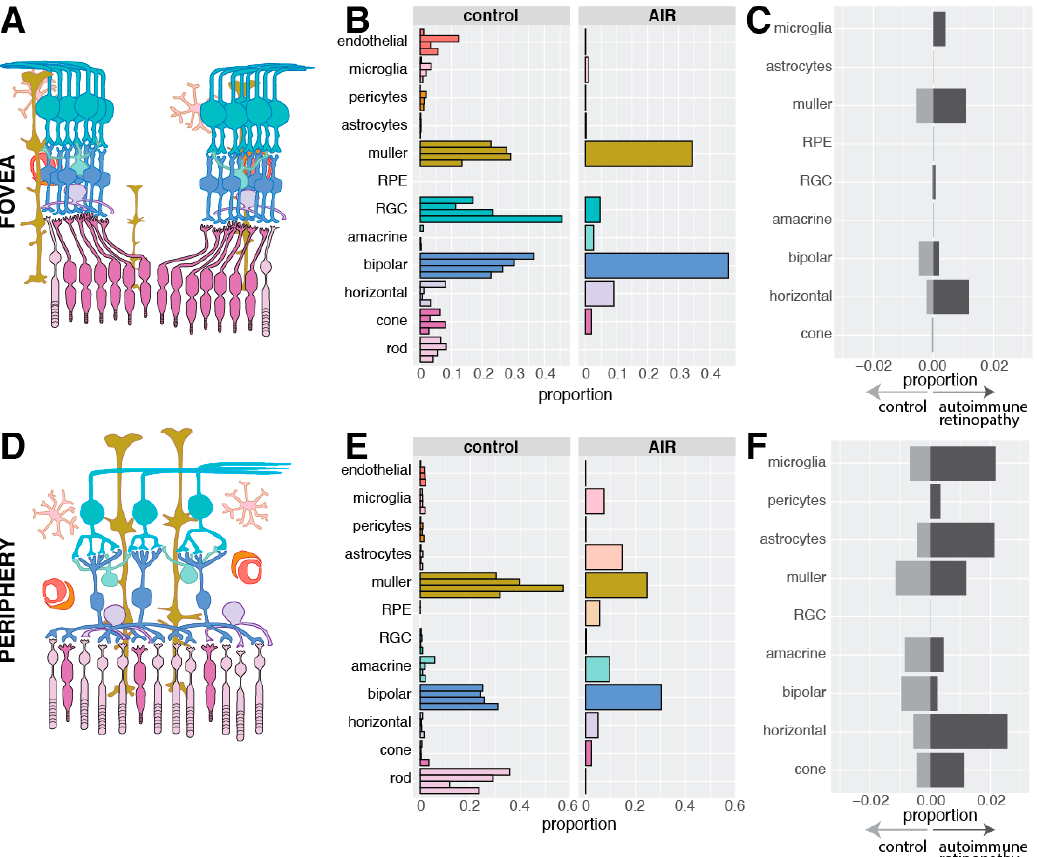
Figure 4. Library composition of recovered cells. ( A ): In the fovea, cone photoreceptor cells synapse with one bipolar cell, which synapse with one retinal ganglion cell. ( B ): The proportion of each cell type recovered from the fovea of the four control donors and the autoimmune retinopathy donor. No foveal rods were recovered from the AIR donor. ( C ): In order to visualize the degree of gene expression differences within each population of cells between the AIR and control donors, differential expression analysis was performed. In each cell type, the number of differentially expressed genes that were enriched in the AIR donor and the control donors were enumerated and divided by the total number of expressed genes (in at least 10% of cells). For example, 1.09% of foveal Müller cell genes were significantly enriched in the AIR donor (dark grey), while 0.57% of foveal Müller cell genes were significantly enriched in the control donors (light grey). ( D ): In the periphery, multiple rod photoreceptor cells synapse with a single bipolar cell. ( E ): The proportion of each cell type recovered from the periphery of the four control donors and the periphery of the AIR donor. ( F ): As in ( C ), the proportion of differentially expressed genes between the AIR and control donors was performed in each cell type. More genes were differentially expressed in the periphery compared to the fovea ( C ). As no RPE cells originated from control donors, differential expression could not be performed in the periphery for this cell type.